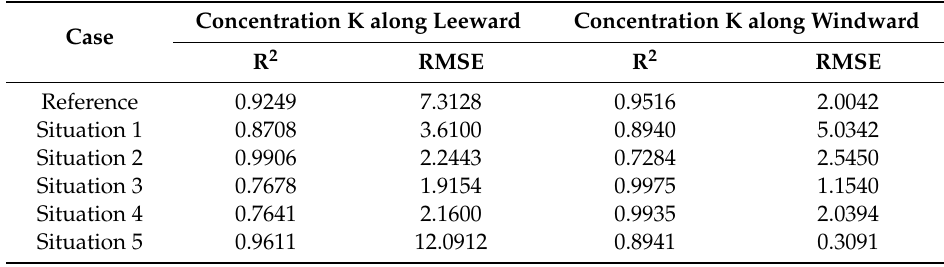
Figure 26. Turbulence kinetic energy of wind flow inside the street canyons with different roof shape configurations. ( a ): Reference case, ( b – f ): Situation 1–5. Table 4. Evaluation of the dimensionless concentration K between the numerical results and experimental data.